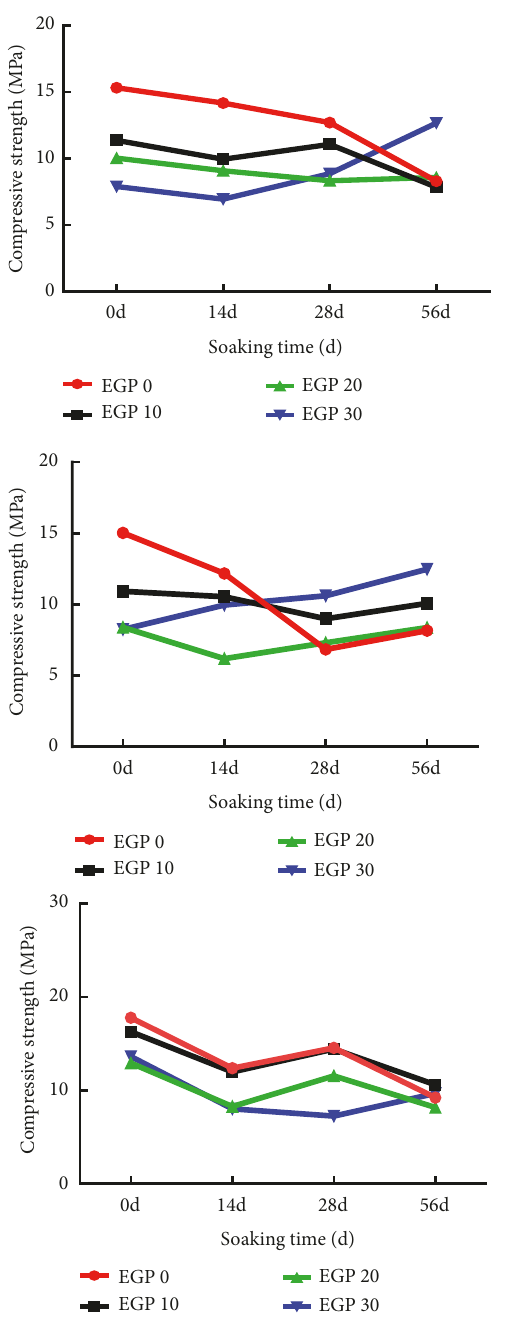
Figure 7: Compressive strength after curing for 1d, 3d, 28d and soaking for 56d.